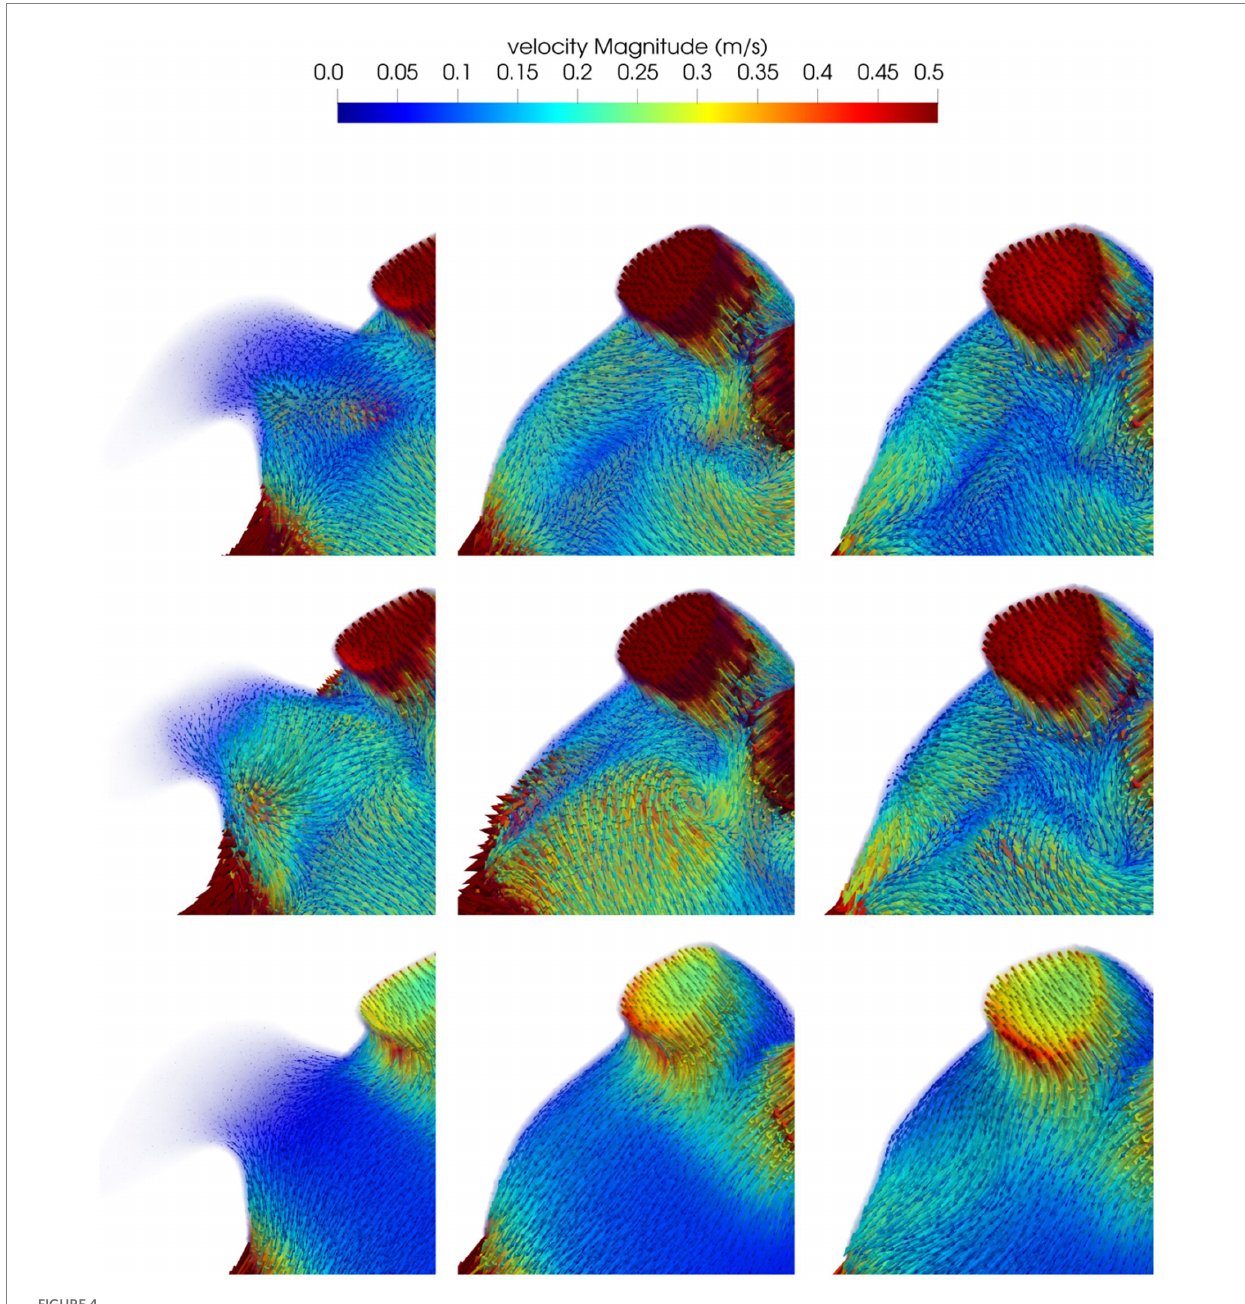
FIGURE 4 Blood flow velocity in the volume of interest close to the closure in a representative patient: in the first column we show the model before the occlusion; the model after the occlusion with the device based on the pacifier principle and the model after the occlusion with the device based on the plug principle are reported in the second and third column respectively. First row refers to the beginning of ventricular diastole, second row to the atrial systole and the third row to the end of atrial